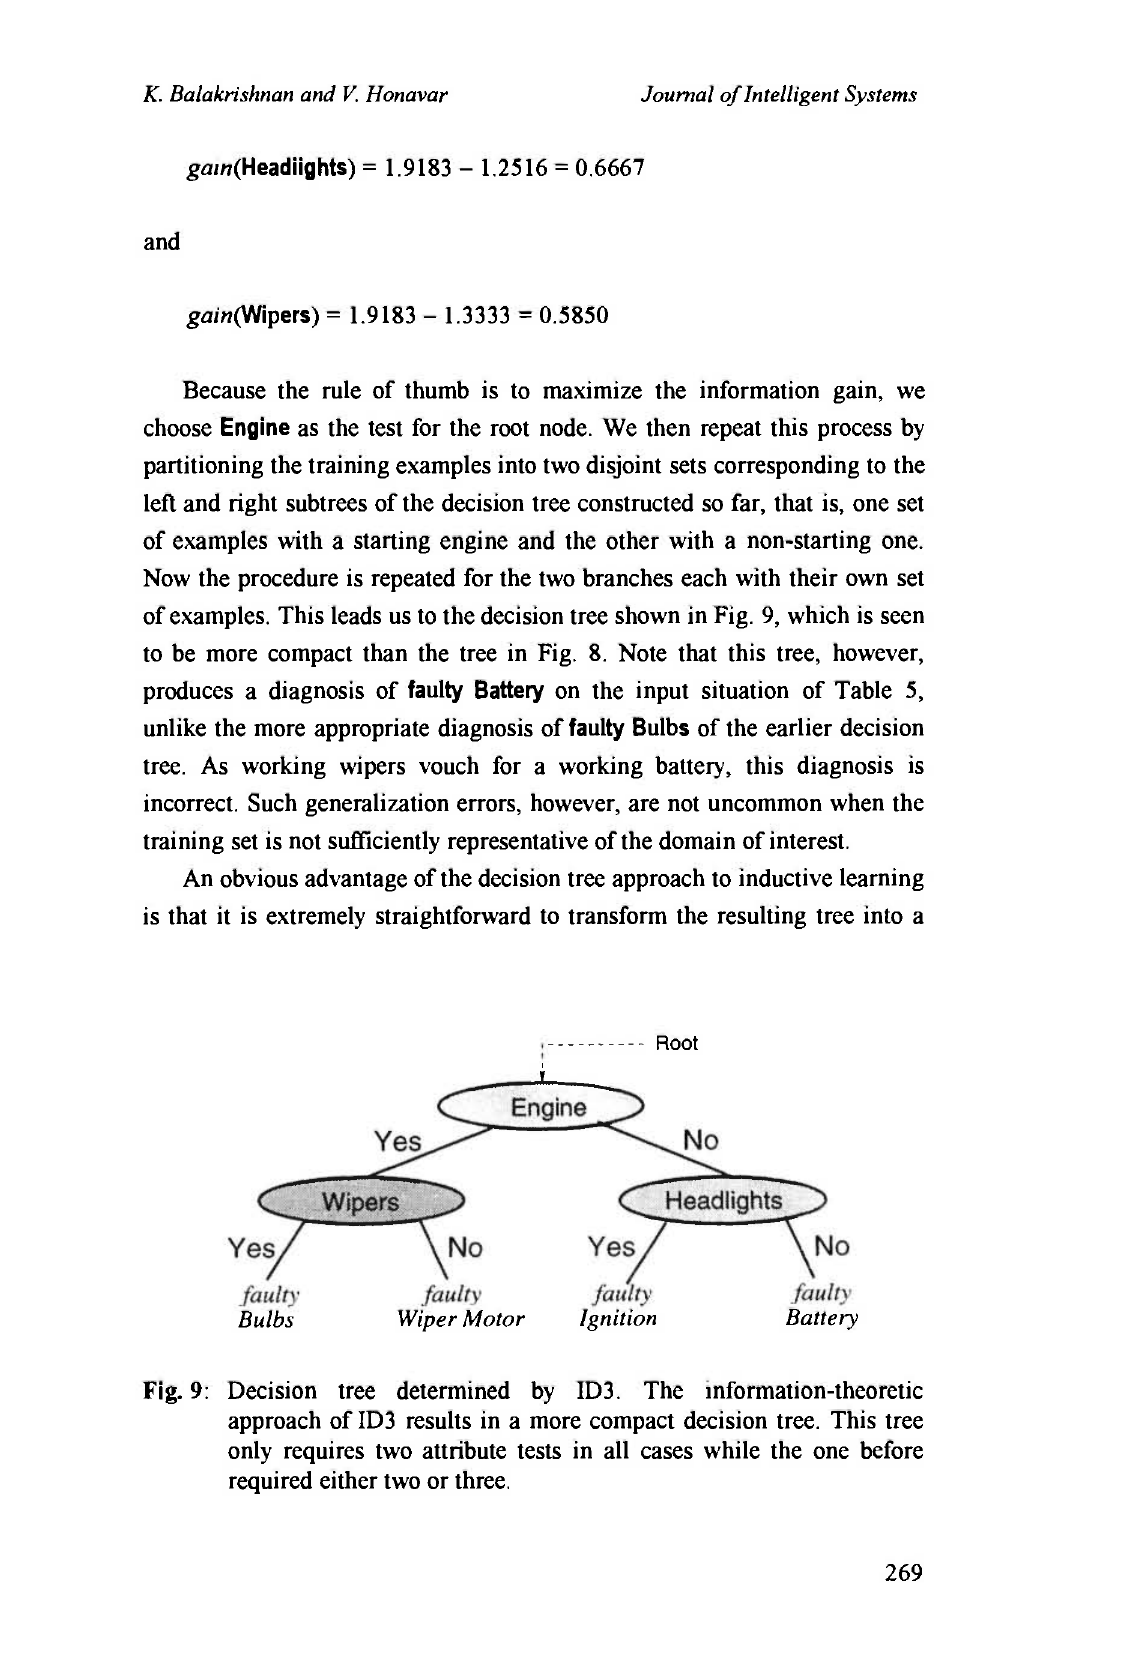
Fig. 9: Decision tree determined by ID3. The